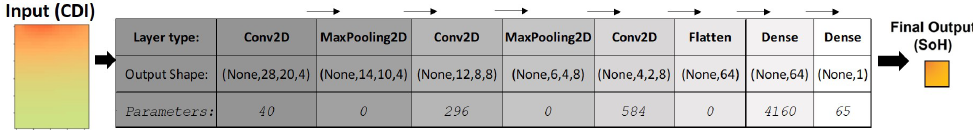
Figure 3. The designed CNN architecture for SoH estimation. The captured CDI from a Li-ion cell is fed into the input layer of the neural network and the final output is the percentage of SoH, presenting the state of health in the corresponding